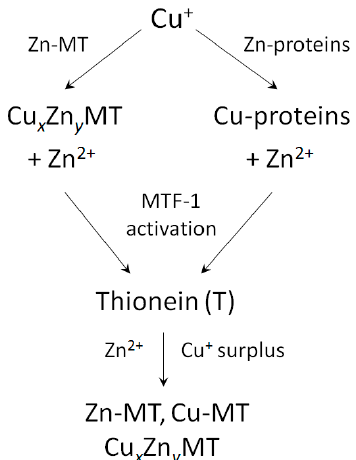
Figure 1. Crosstalk between Cu + fluxes and zinc proteins (including Zn-MT). Released Zn 2+ activates the metal-response element (MRE) binding transcription factor-1 (MTF-1) transcription factor, which promotes biosynthesis of thionein (apo-metallothionein). In vivo-synthesized thionein interacts with released Zn 2+ and Cu + surplus forming metamorphic forms of metallothioneins.